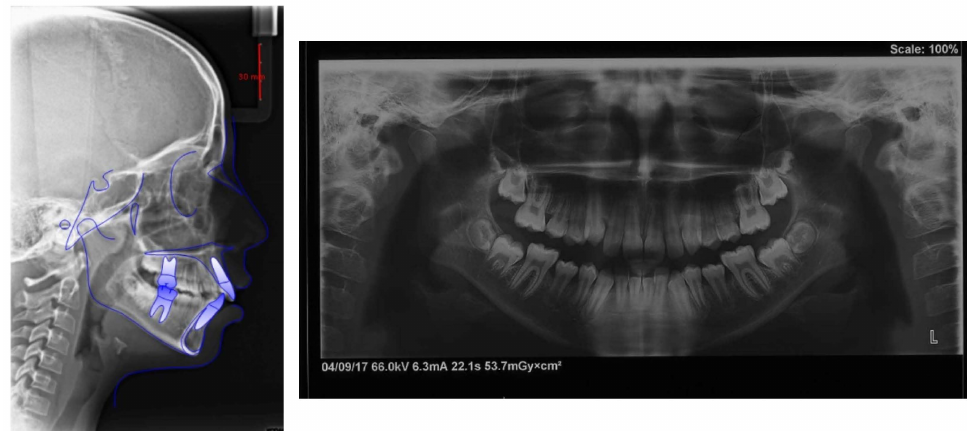
Figure 6. Pre-treatment lateral cephalogram and panoramic radiograph.